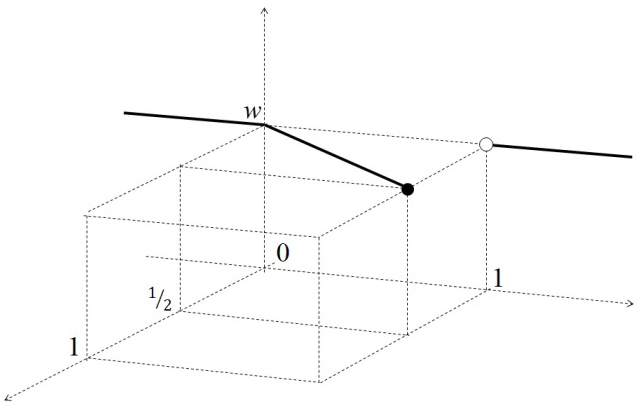
Figure 5. Example of a T2FS that is a T2GFN in C w